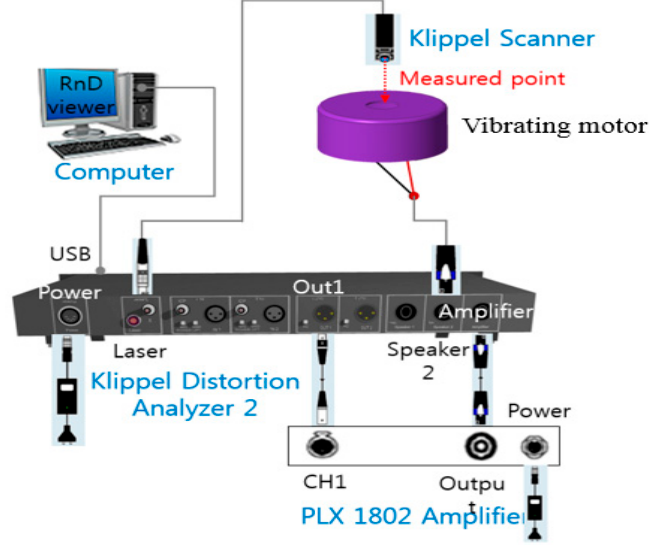
Figure 8. Experimental equipment setup.